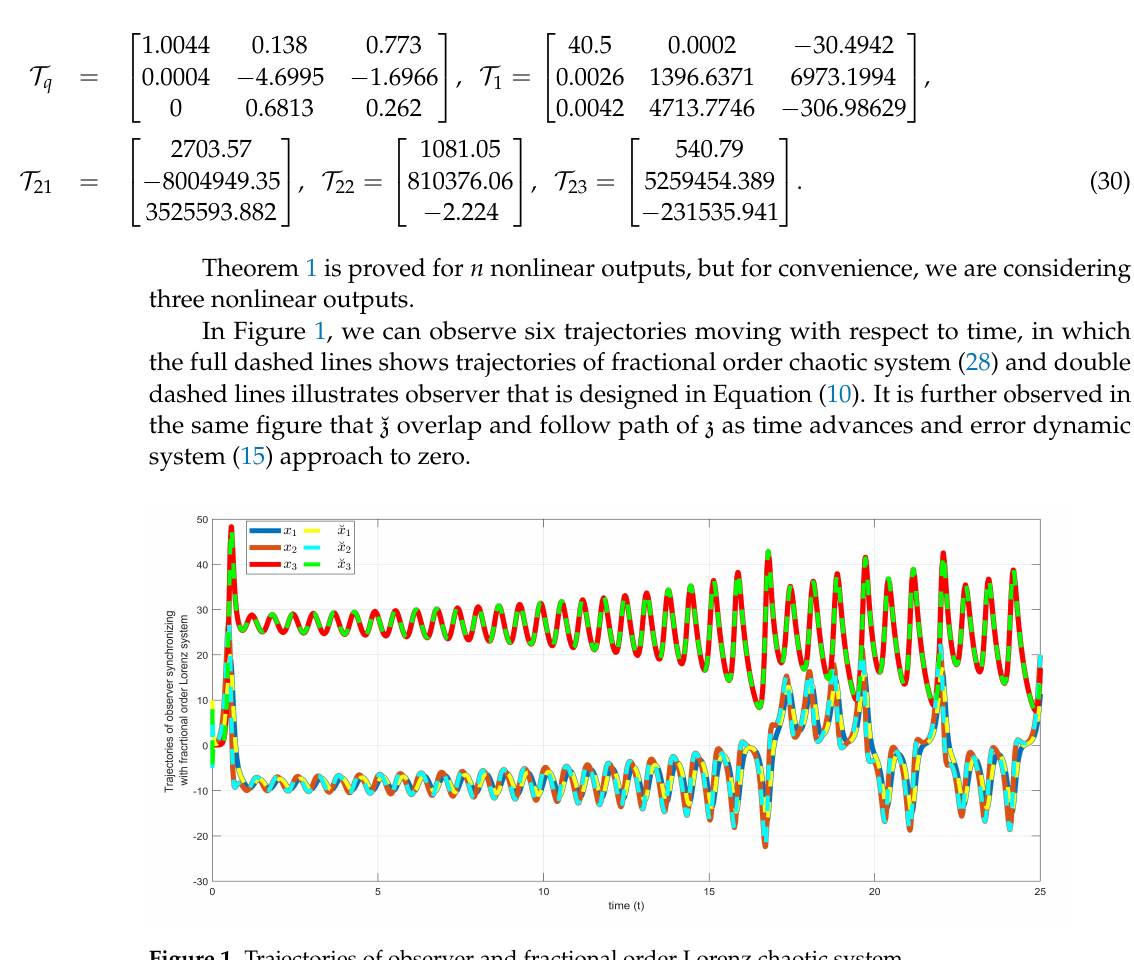
Figure 1. Trajectories of observer and fractional order Lorenz chaotic